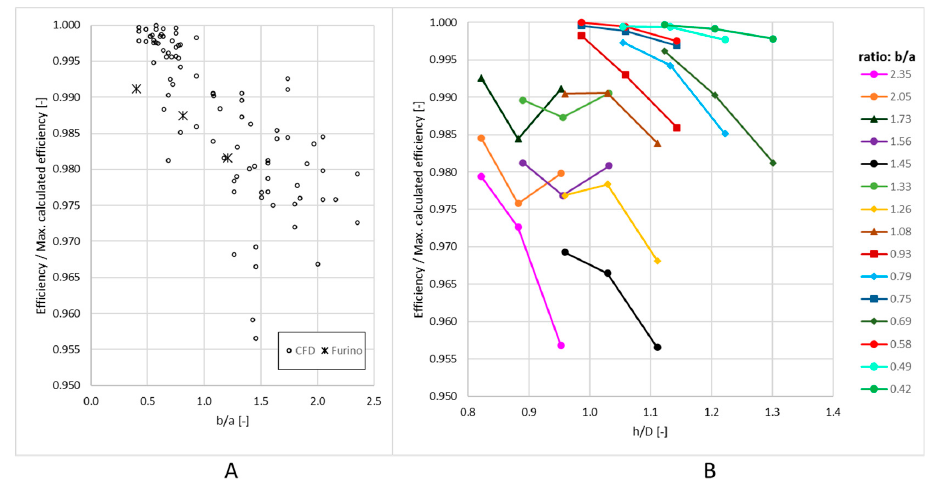
Energies 2022 , 15 , x FOR PEER REVIEW Figure 9. ( A ) b / a ratio impact on efficiency; ( B ) h / D ratio impact on efficiency. Figure 10 shows the effect of geometric parameters on the 𝑂𝑄 relative value. For the analysed changes in the separator geometry, a decrease was observed in relative 𝑂𝑄 of about 0.15 when 𝑏/𝑎 (cid:3408) 1 . For 𝑏/𝑎 (cid:3407) 0.5 , the 𝑂𝑄 highest relative value of more than 0.95 was observed (Figure 10A). Analysing the impact of ℎ/𝐷 , it was noticed that 𝑂𝑄 im- proved with an increase in the ℎ/𝐷 ratio, and above the value of 1.2, it exceeded 0.9. For ℎ/𝐷 (cid:3408) 0.99 and 𝑏/𝑎 (cid:3407) 1 , the recorded oil quality values exceed 0.85 (Figure 10B).